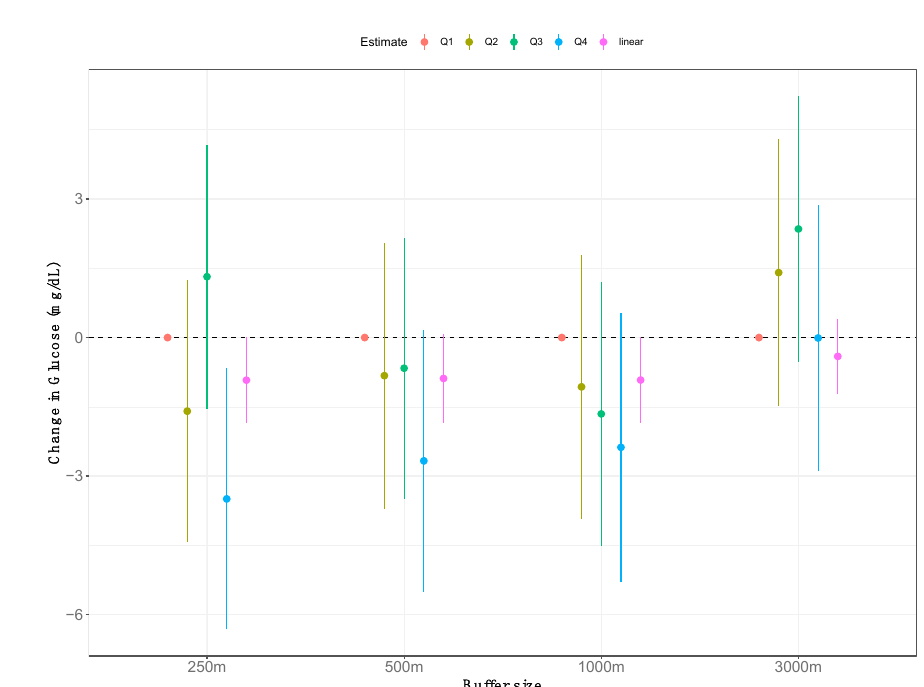
Figure 3. Estimated changes in glucose levels associated with exposure to greenness measured at different buffer sizes (e.g., 250, 500, 1000, and 3000 m) from linear regression models adjusted for age, gender, Hispanic ethnicity, race, and socioeconomic status (maternal education level and income over poverty ratio. Results are presented for quartiles of exposure with the first quartile of exposure as the referent category with dots representing the effect estimate and whiskers representing 95% confidence intervals. Results from a linear term for the exposure as a continuous variable (in pink) are also presented for change in glucose associated with an interquartile range increase in exposure at each buffer size.